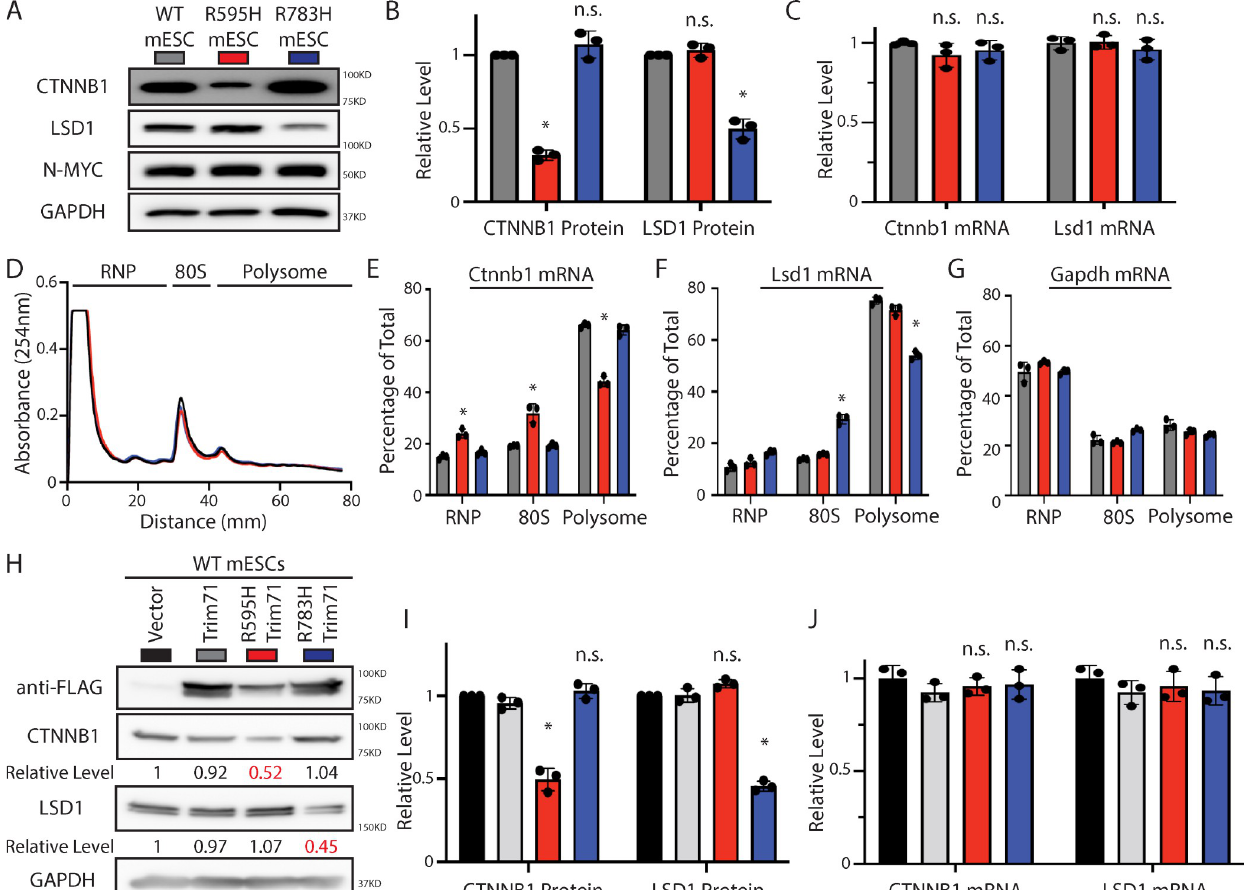
Fig 4. The two Trim71 mutants represses the translation of different mRNAs in mESCs. ( A ) Western blotting in the WT, R595H, and R783H mESCs. The cells were cultured in the 2i + Lif medium. The color code displayed in the panel are used in all the other panels of the figure. ( B , C ) Quantification of the protein (B) and mRNA (C) levels of Ctnnb1 and Lsd1 in the cells cultured in the 2i + Lif medium. GAPDH and 18S rRNA were used for normalization in protein and mRNA quantifications, respectively. ( D ) Polysome analysis in the WT and the two mutant mESCs cultured in the 2i + Lif medium. ( E , G ) Quantification of the indicated mRNA distribution in the RNP, 80S, and polysome fractions from the WT and the two mutant mESCs. ( H ) Western blotting in the WT mESCs expressing an empty vector, Flag-Trim71, Flag-Trim71(R595H), and Flag-Trim71(R783H). The cells were cultured in the 2i + Lif medium. ( I , J ) Quantification of the protein (I) and mRNA (J) levels of Ctnnb1 and Lsd1. GAPDH and 18S rRNA were used for normalization in protein and mRNA quantifications, respectively. The quantification results in B, C, E, F, G, I, and J represent the means ( ± SD) of three independent experiments. � p < 0.05; and n.s. not significant ( p > 0.05) by one-way ANOVA. See also S6 Fig. The data for B-G and I-J are available in S3 Data. mESC, mouse embryonic stem cell; WT,